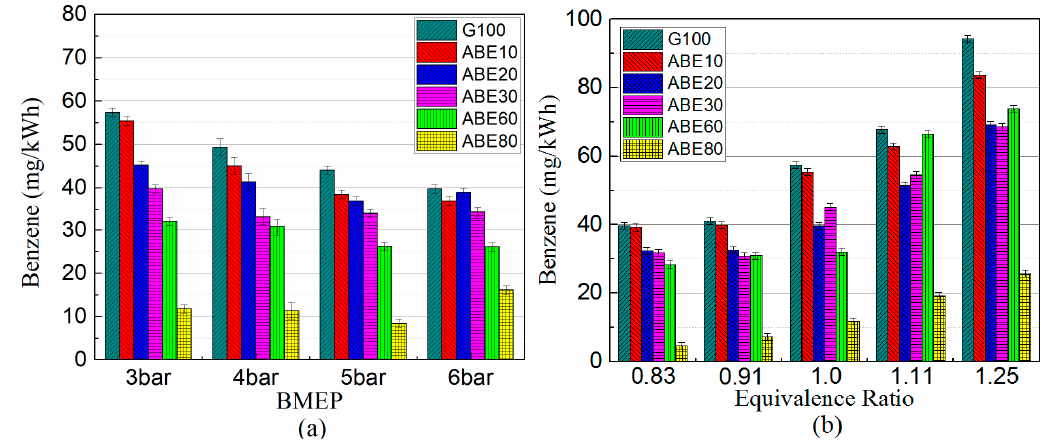
Figure 7. Benzene emissions at ( a ) stoichiometric conditions under different BMEP, and at ( b ) 3 bar BMEP under different equivalence ratios. BMEP under different equivalence